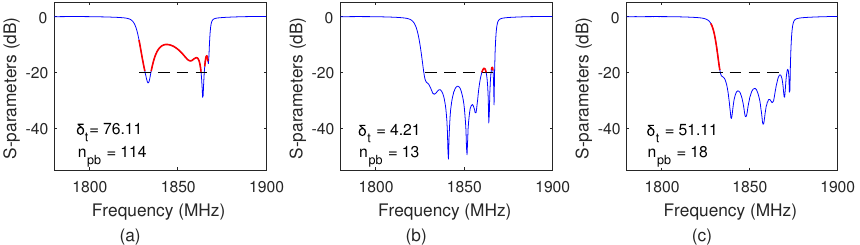
Figure 9. Simply computing the Euclidean distance is not appropriate to evaluate the case when the S–parameters curve has a horizontal shift. The curve in ( a ) has the largest distance since the central part is far from the target line. The curve ( b ) has the smallest distance since only small portion of the points are above the target line. The S 11 curve in ( c ) has a slight shift to the right but the computed distance becomes relatively high. Red parts indicate the points involved in the calculation of r distance